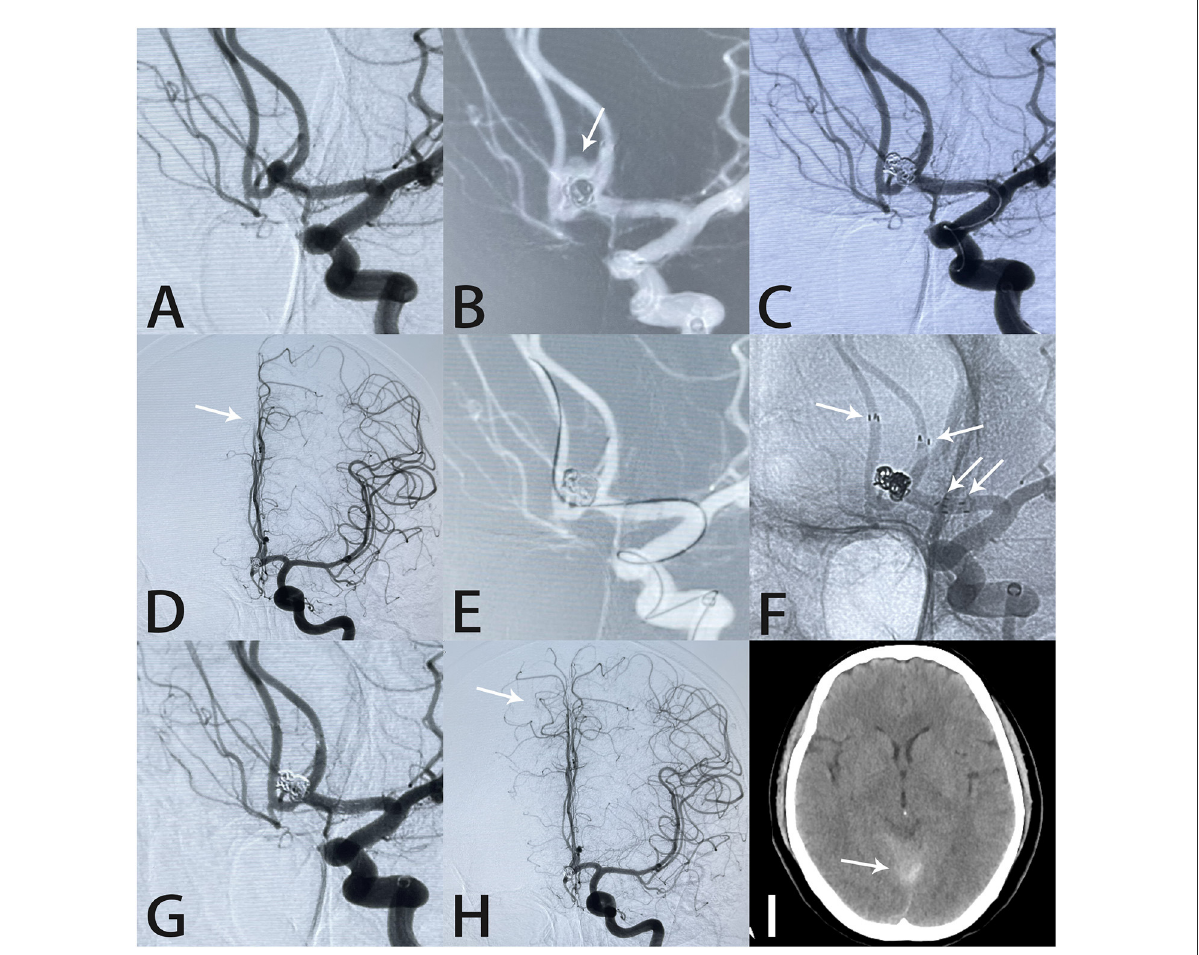
FIGURE3 Images from a 56-year-old woman with a tiny anterior communicating artery aneurysm. Angiography demonstrated an anterior communicating artery aneurysm (A) . The aneurysm (white arrow) ruptured during coil placement (B) . Rapid deployment of additional coils controlled the hemorrhage (C) . Intraprocedural angiography showed slow blood flow in the A2 segment of the right anterior cerebral artery (white arrow) (D) . An Echelon-10 microcatheter was navigated into the right anterior cerebral artery in preparation for Atlas stent deployment (E) . Two Atlas stents formed a “Y-shape” (white arrows) (F) . Angiography immediately after the procedure showed complete aneurysm occlusion and unobstructed blood flow in the A2 segment (white arrow) (G,H) . Postprocedural computed tomography showed subarachnoid hemorrhage in the tentorium cerebelli (I)